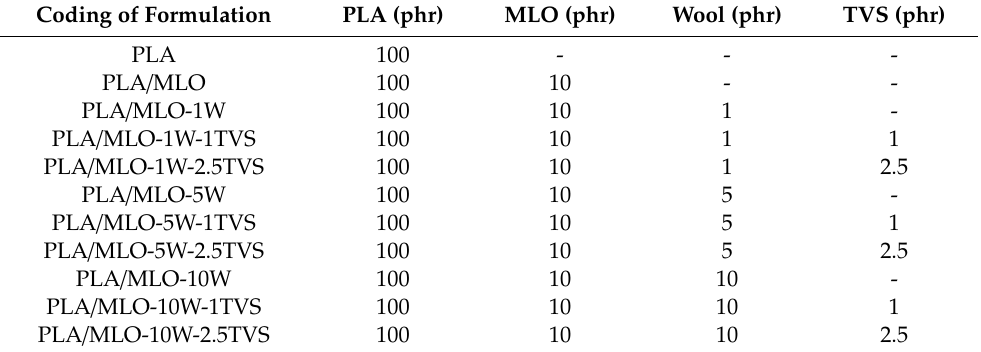
Table 1. Summary of the compositions and labeling of PLA / MLO–wool formulations. Coding of